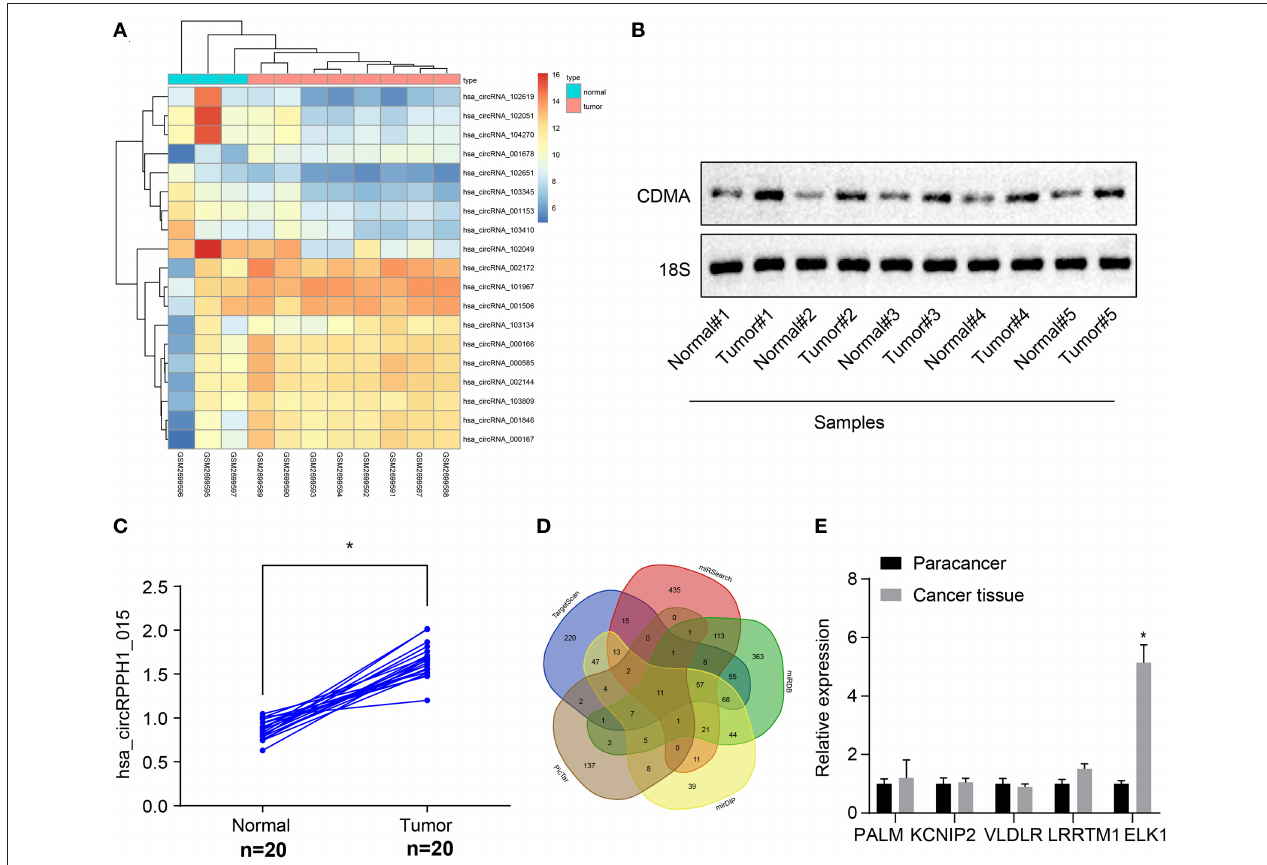
FIGURE 1 | Bioinformatics revealed a possible regulatory mechanism involving hsa_circRPPH1_015, miR-326, and ELK1 in BC. (A) The heat map of the microarray GSE110123. (B) Representative image of the northern blot analyses of hsa_circRPPH1_015 expression performed using five tumor tissues and adjacent normal tissues ( N = 5). (C) Quantification of northern blot analyses of hsa_circRPPH1_015 expression performed in 20 tumor tissues and adjacent normal tissues ( N = 20). (D) Prediction of the target genes of miR-326 using MirDIP database, TargetScan database, miRSearch database, miRDB database, and PicTar database. (E) The expression of PALM, KCNIP2, VLDLR, LRRTM1, and ELK1 obtained from the GSE35412 dataset determined by RT-qPCR. * p < 0.05 vs. normal or adjacent normal tissues. The above data were all measurement data and expressed as mean ± standard deviation, and the paired t -test was used for comparison between cancer tissues and adjacent normal tissues. Values were obtained from three independent experiments. BC, breast cancer; ELK1, ETS-domain containing protein; KCNIP2, Kv (potassium) channel interacting protein 2; VLDLR, very low-density lipoprotein receptor; LRRTM1, leucine rich repeat transmembrane neuronal 1; RT-qPCR, reverse transcription quantitative polymerase chain